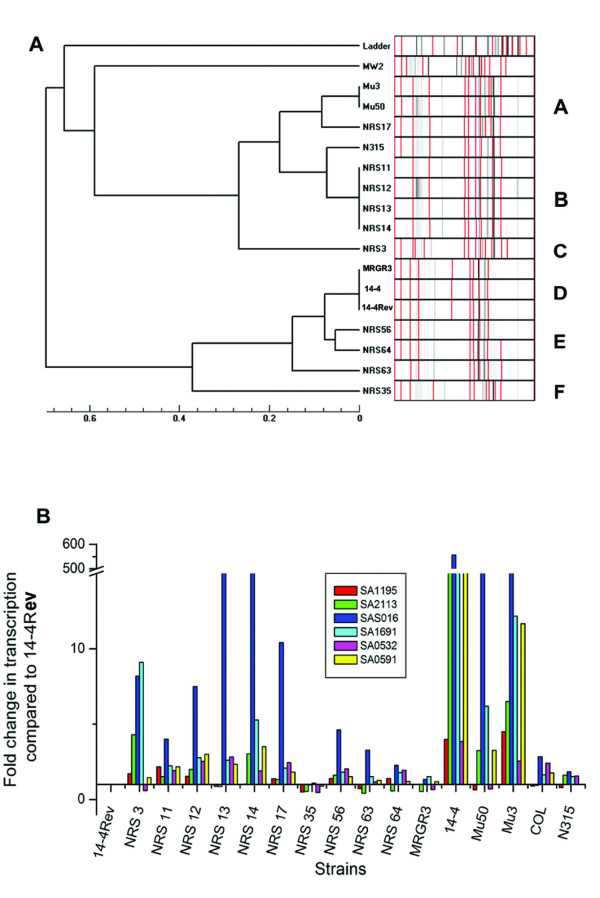
A. Genotyping of strains evaluated by VNTR. Based on the limit of clonality of the assay (0.1 unit of divergence) [77], our collection contains at least 4 unrelated genetic backgrounds (noted A-D). Control strains whose genome has been sequenced have been simultaneously analyzed. B. Gene expression of identified markers on a collection of strains showing altered susceptibility to glycopeptides. Relative expression of 6 gene markers found up-regulated in the resistant strain 14-4 compared to the two sensitive strains. The same markers were also quantified in a collection of strains from the NARSA, selected for their resistance to glycopeptide. Values are mean + standard deviation of triplicate measurements from 2 independent experiments. Increase expression of selected markers, linked to glycopeptide resistance is independent on the background. The complete raw microarray dataset has been posted on the Gene Expression Omnibus database [78], accession number GSE5188. All additional files are freely accessible [79].